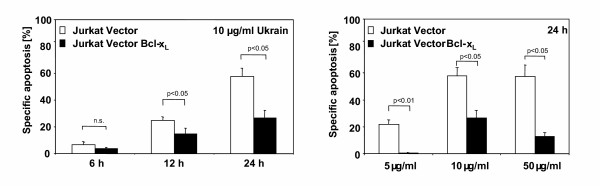
Overexpression of BclxL reduces Ukrain induced apoptosis. Jurkat Vector cells and Jurkat cells overexpressing anti-apoptotic Bcl-xL (Jurkat Bcl-xL) were treated with 10 μg/ml Ukrain for 6, 12 and 24 h (left panel) or for 24 h with 5, 10 and 50 μg/ml Ukrain (right panel). Apoptosis was then measured by fluorescence microscopy upon Hoechst33342-staining. Data show means ± SD (n = 3). Paired t-test was performed using GraphPad InStat version 3.00 for Windows 95, GraphPad Software, San Diego California USA, ).